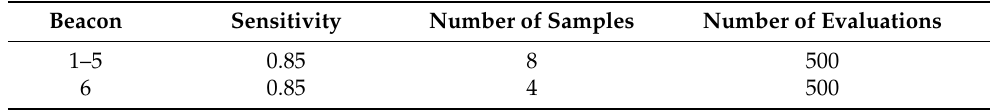
Table 7. Beacon Calibration Tool parameter settings.